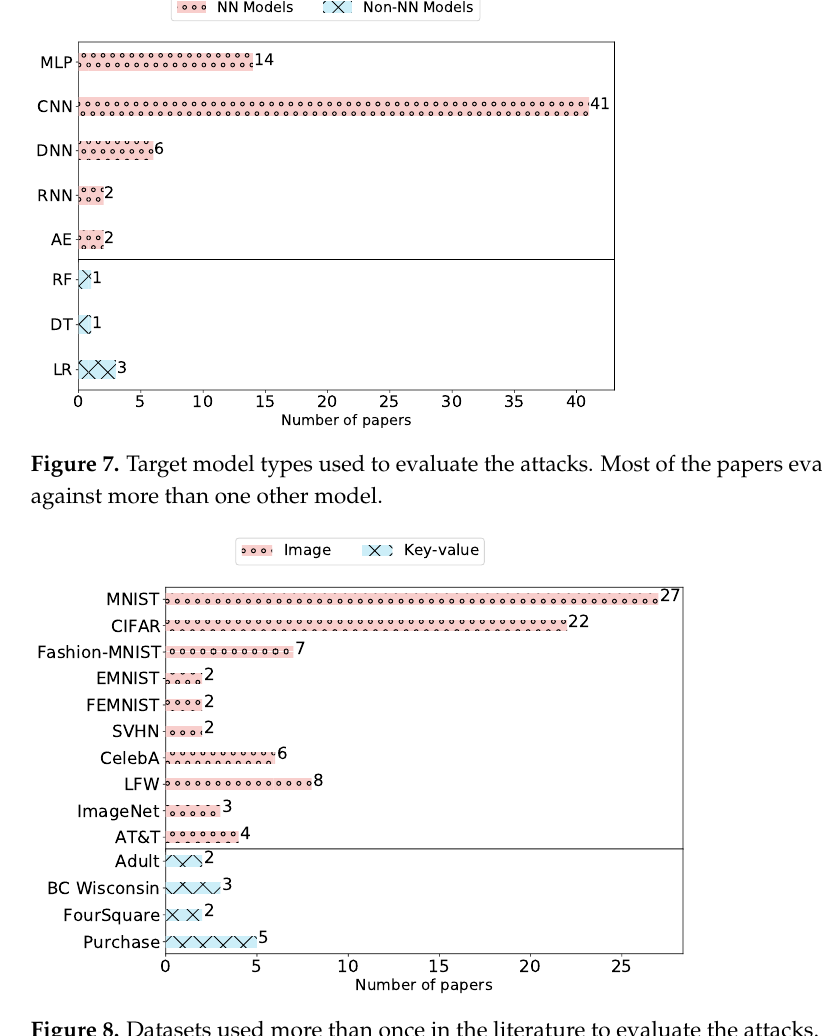
Figure 8. Datasets used more than once in the literature to evaluate the attacks. Most of the papers were evaluated using more than one dataset.